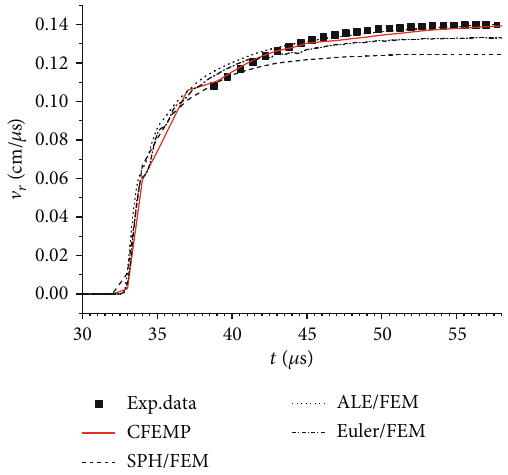
Figure 6: The wall-expanded speed-time curve at the